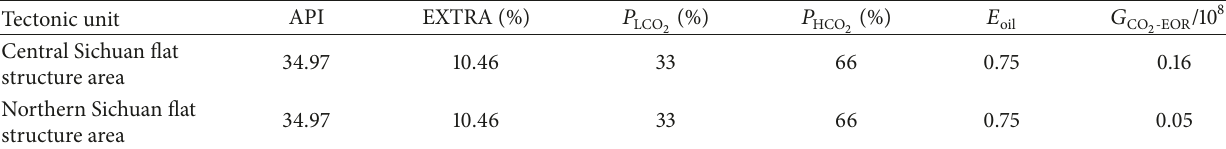
Table 10: CO 2 -EOR geological storage potential in the Sichuan